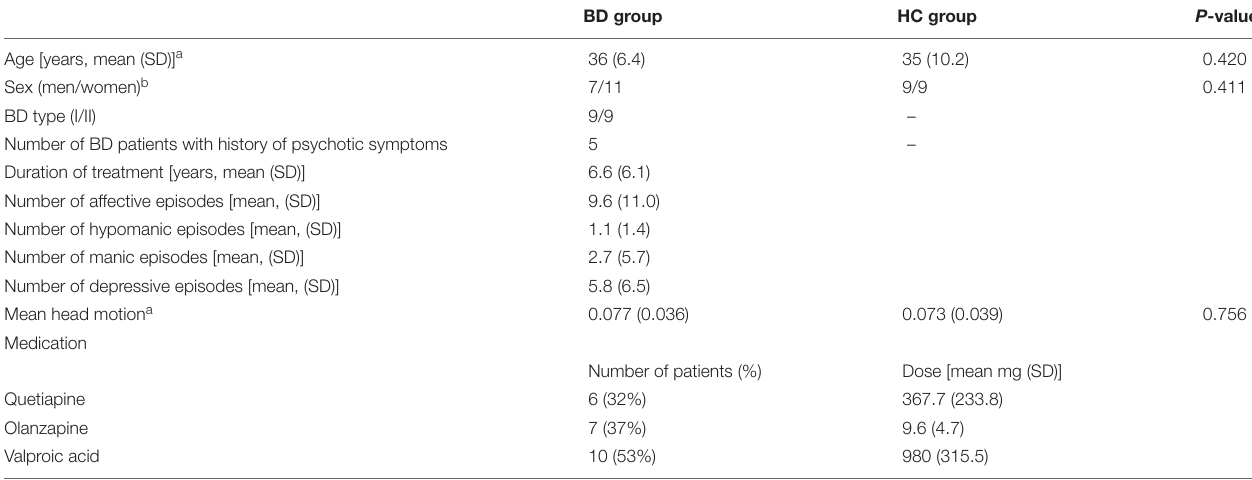
TABLE 1 | The description of study